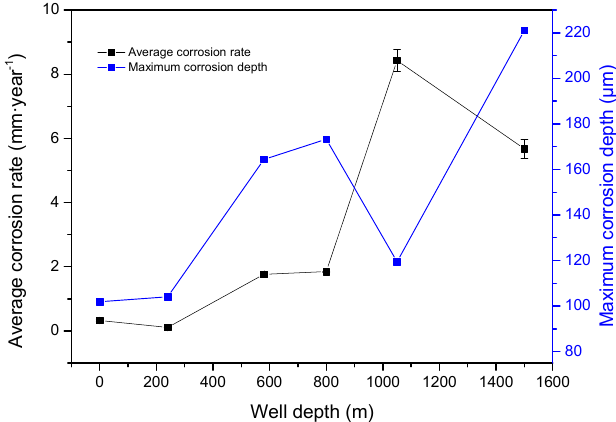
Figure 5. Average corrosion rate and maximum corrosion depth at different well depths.